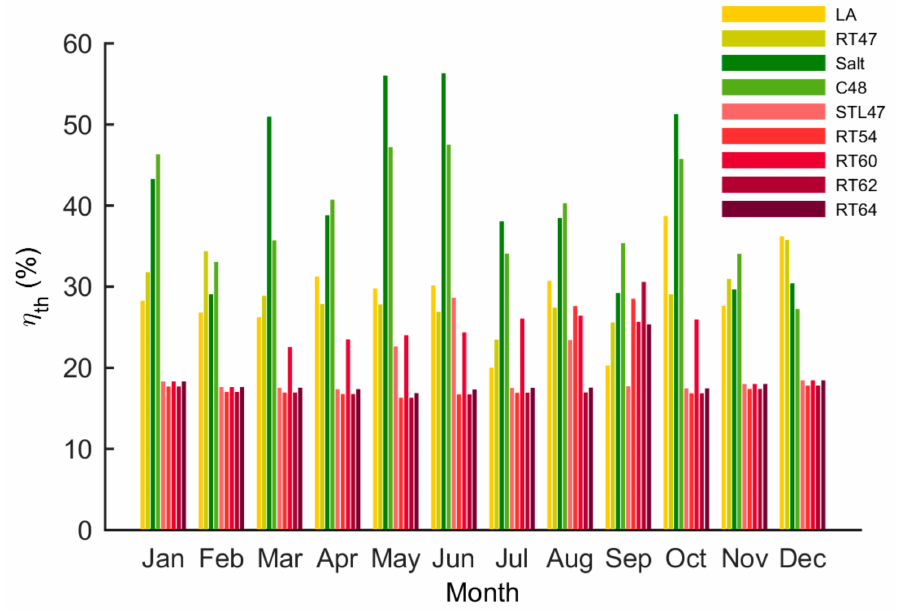
Figure 12. Comparison of the thermal efficiency of a CPVPCM